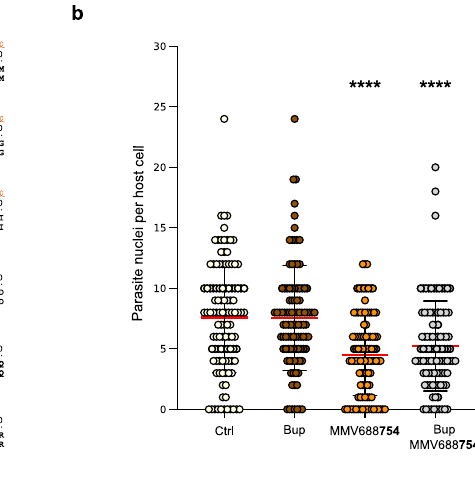
Fig. 8 MMV668754/Tri fl oxystrobin and Buparvaquone may have distinct target inhibition. a Sequence alignment of parasite TaCytB protein sequences from TBL3 cells and Buparvaquone-resistant TBL3 cell lines. Positions of the mutations are highlighted in red. b Parasite load per infected host cell in Buparvaquone-resistant TBL3 cell line. Parasite number was evaluated after drug treatment (2 µ M for 48 h) compared to DMSO (Ctrl) or